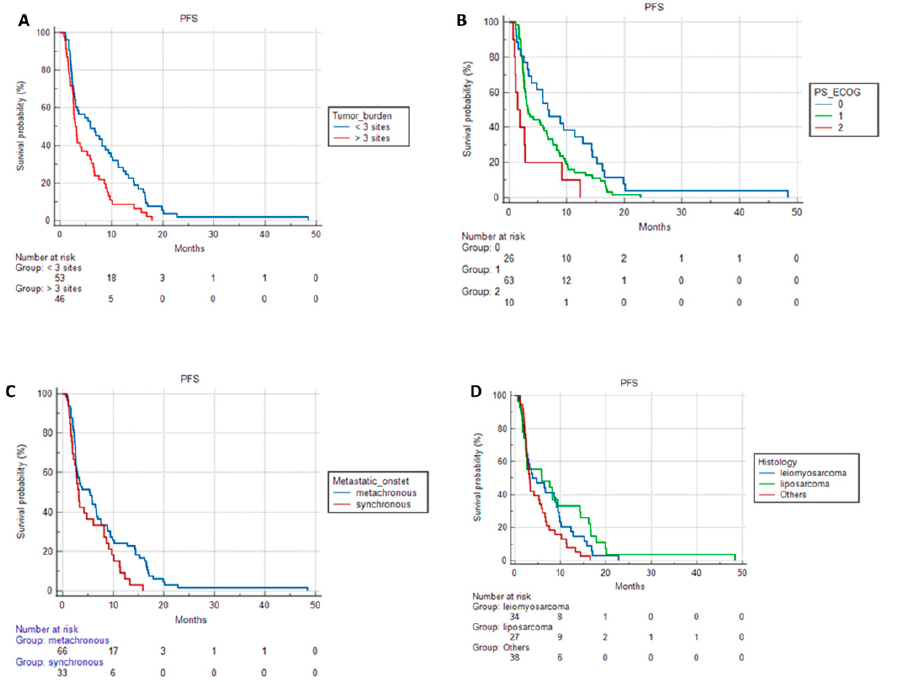
Figure 1. PFS according to ( A ) tumor burden; ( B ) PS ECOG; ( C ) metastatic onset; ( D ) histology.